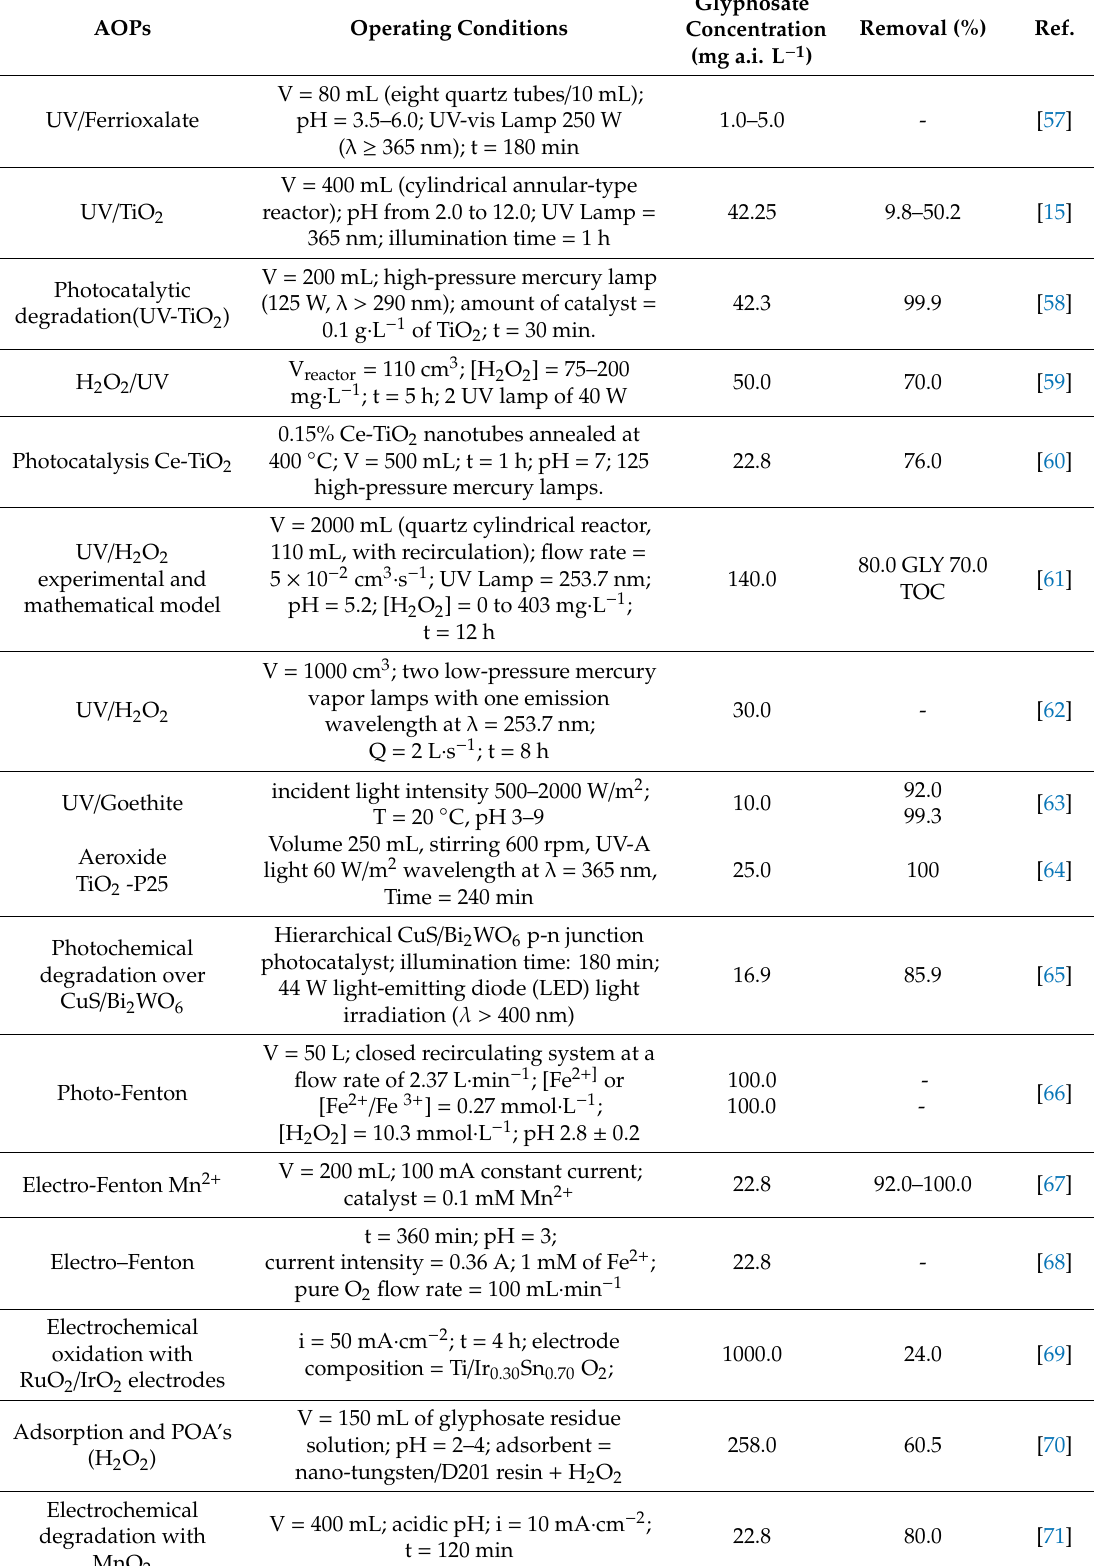
Table 4. Removal of glyphosate from water polluted by advanced oxidation processes